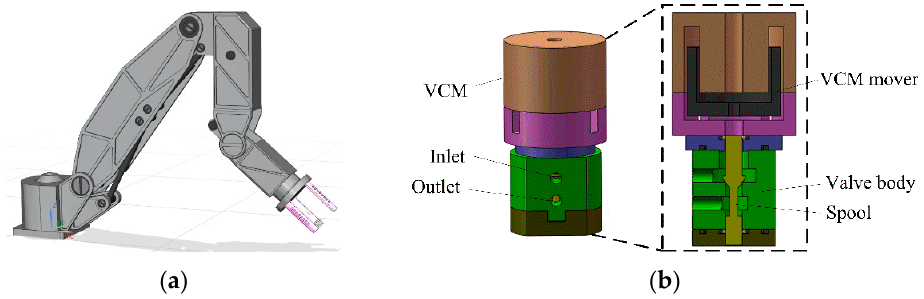
Figure 4. Three ‐ dimensional model. ( a ) Water hydraulic manipulator. ( b ) Water hydraulic HSV.